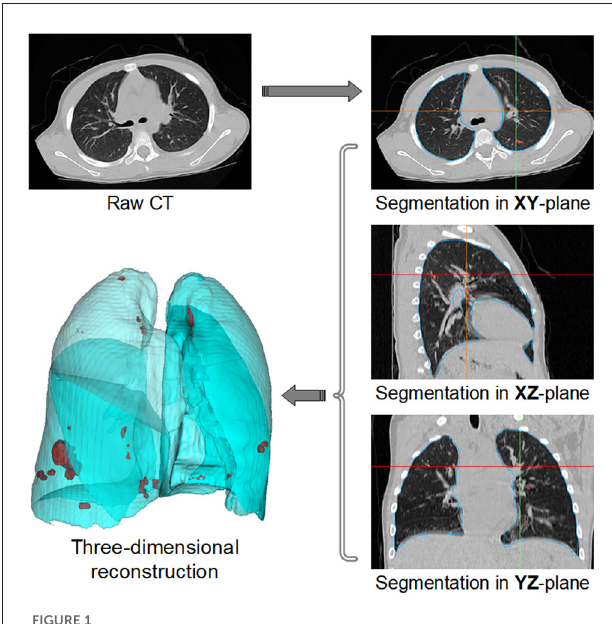
FIGURE1 Workflow of traditional lesions segmentation.